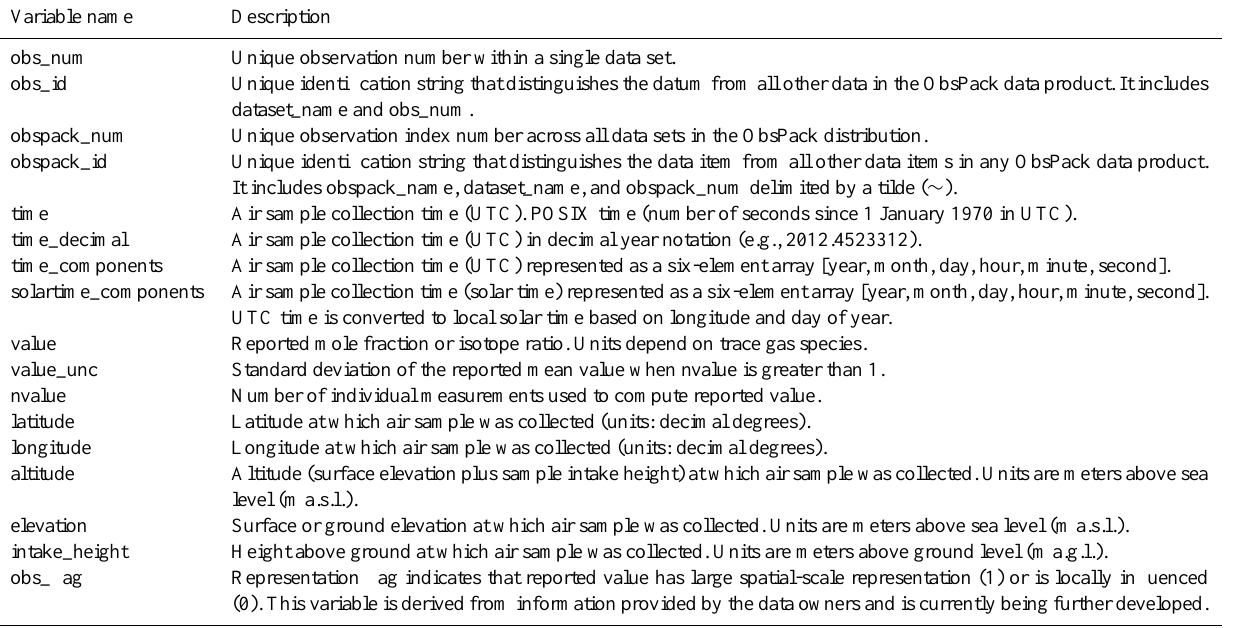
Table 3. Partial list of variables included in an ObsPack data